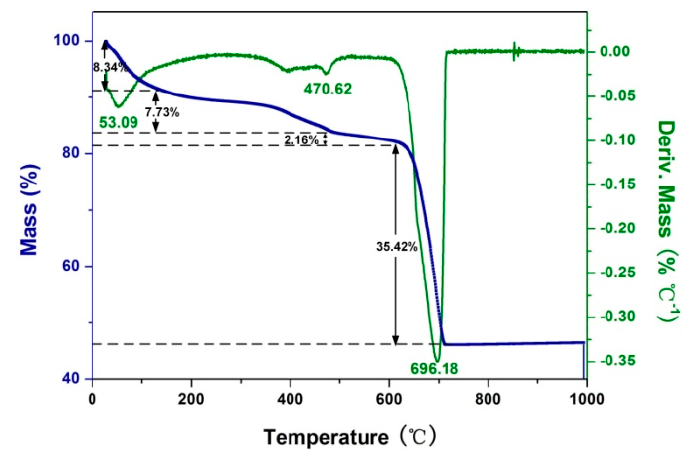
Figure 3. TGA and DTG curves of Rod-CC NPs.